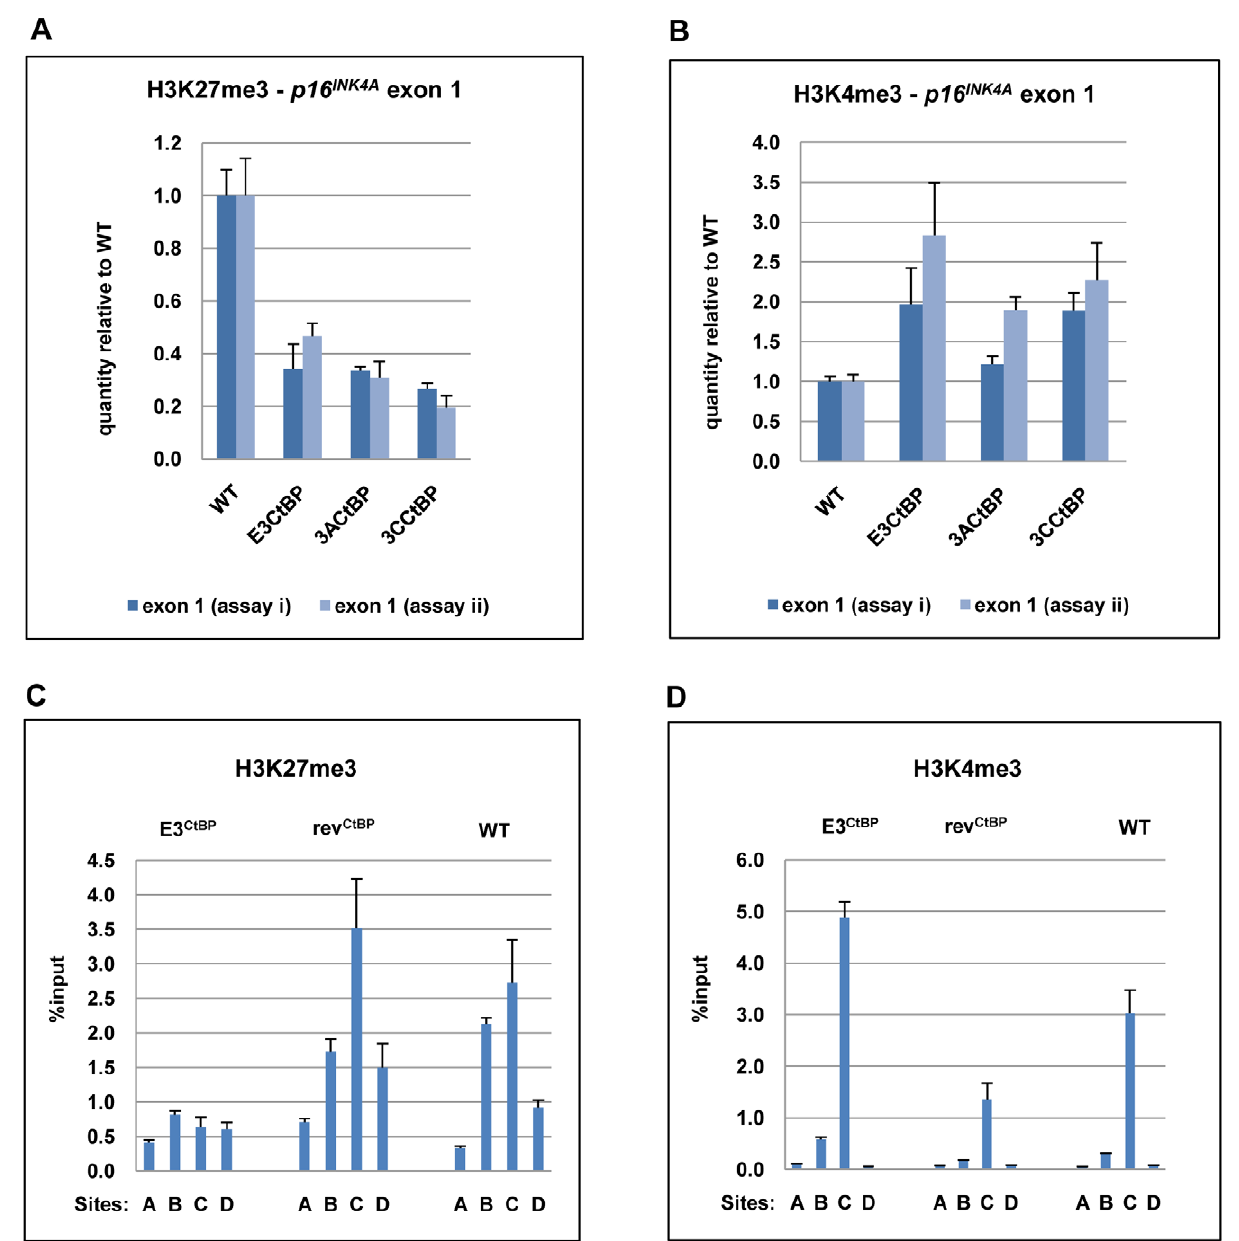
Figure 10. The interaction of EBNA3A and EBNA3C with CtBP is necessary for the chromatin remodelling associated with the repression of p16 INK4A . ( A ) & ( B ) ChIP analysis of H3K27me3 and H3K4me3 in p16 INK4A exon 1 (site C) performed in duplicate (assays i & ii) on an E3 CtBP LCL, a 3A CtBP and a 3C CtBP . Similar analysis of a WT-EBV LCL is shown for comparison. ( C ) & ( D ) ChIP anaysis of H3K27me3 and H4Kme3 distribution across the p16 INK4A -ARF locus in an E3 CtBP LCL. Similar assays performed on revertant (rev CtBP ) and WT-EBV LCLs are shown for comparison. The sites correspond to those shown in Figure 5A.